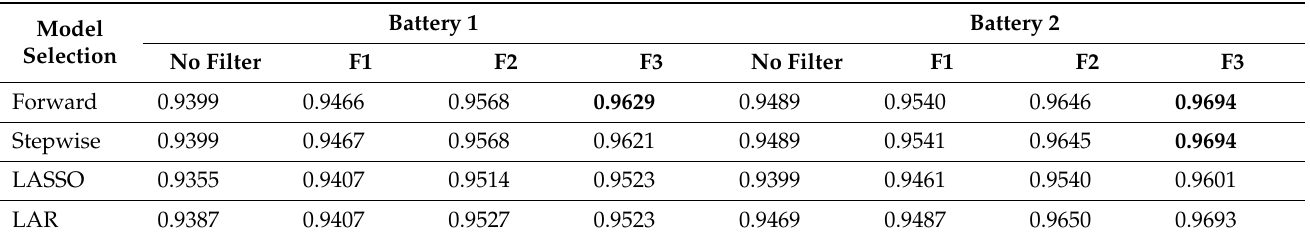
Table 4. Experiment results (Adjusted